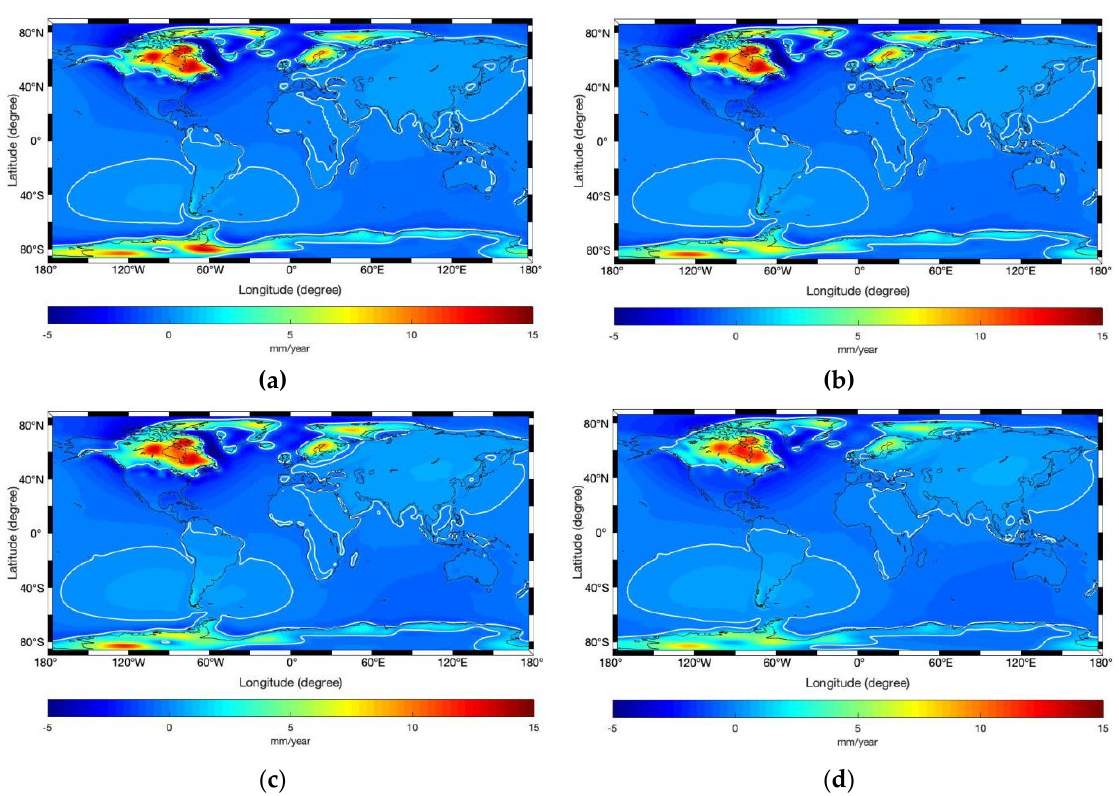
Figure 1. Glacial isostatic adjustment (GIA) uplift rates as predicted by four variants of the ICE-6G models. ( a ) ICE6GC; ( b ) ICE6GD; ( c ) PUR16; ( d ) PUR18. The zero-motion contours are indicated by white curves. Despite visible differences for some local details, all the four model predictions agree with each other at the global scale.